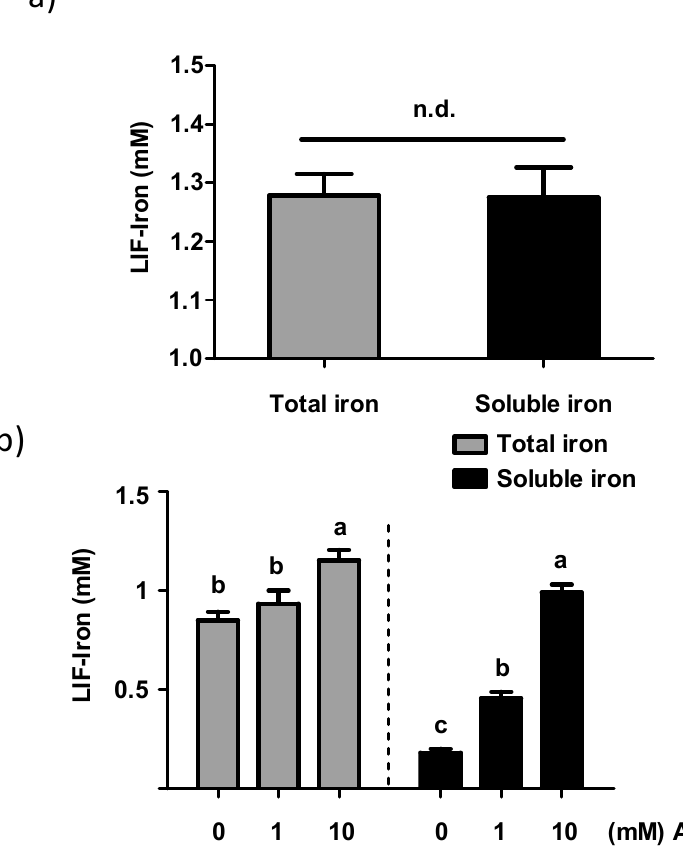
Figure 2. Concentration of total and soluble iron from the iron ingot (Lucky Iron Fish™ (LIF)) at ( a ) pH 2 and ( b ) pH 7 with or without AA. Data represent means ± SEM ( n = 4). Means without a common letter differ ( p < 0.05). n.d. means not statistically different.